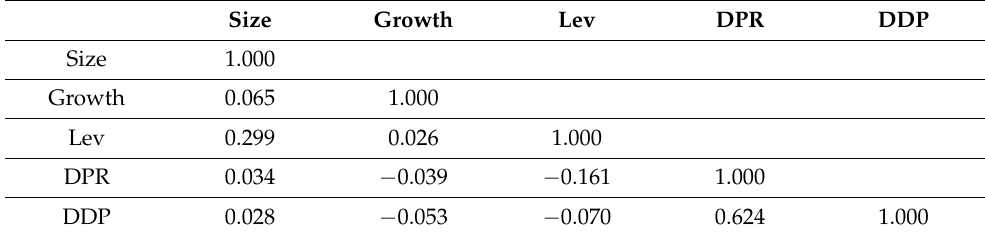
Table 2. Correlation matrix between independent variables.